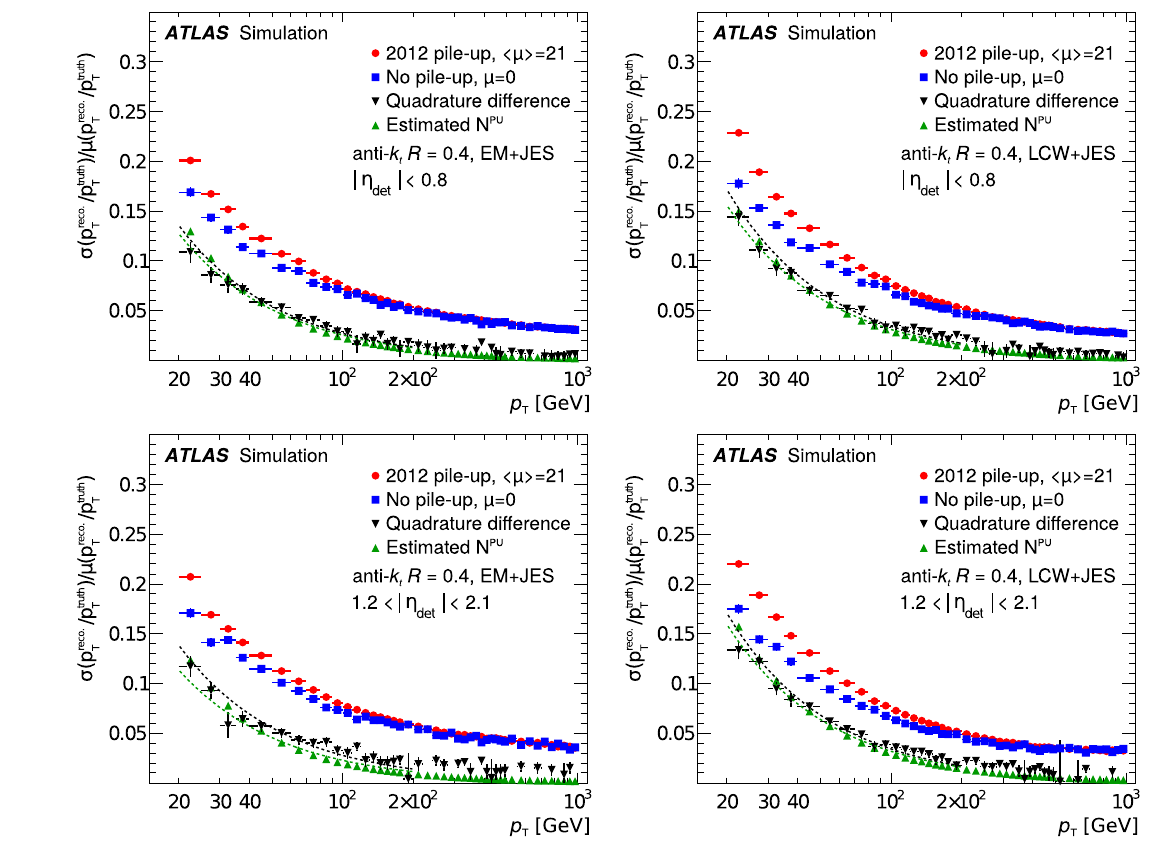
Fig. 54 Comparison between the pile-up noise term N PU extracted simulation of events with nominal pile-up (circles) from that of events with no pile-up (squares). Fits performed to the measured and expected using the random cone method (upward triangles) with the expecta- pile-up noise data are displayed as dotted curves. Quadrature differ- tion from MC simulation (downward triangles). Results are shown for ences corresponding to points where, due to statistical fluctuations, the jets built from EM (left) and LC (right) topo-clusters, for jets with | η | < 0 . 8 (top) and 1 . 2 < | η | < 2 . 1 (bottom). The expected N PU resolution is worse in the no pile-up scenario are not displayed det det is obtained by quadrature subtraction of the JER obtained from MC